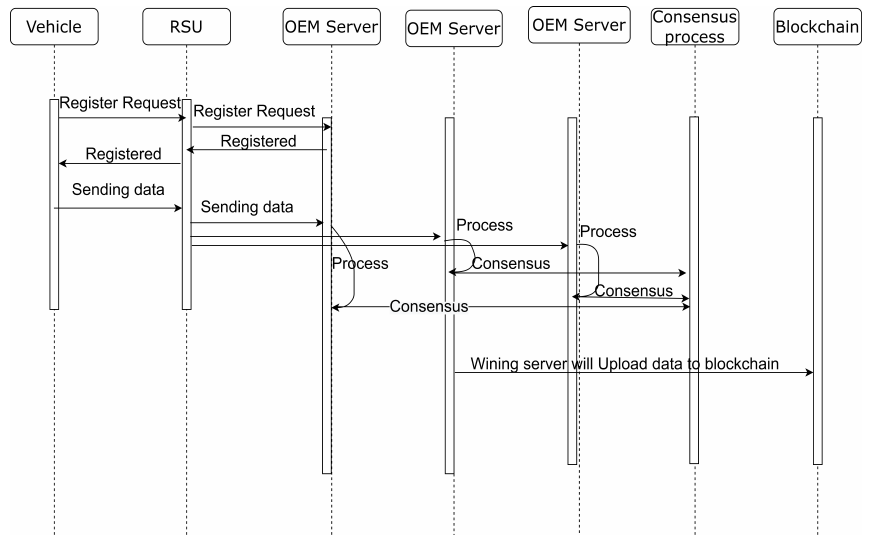
Figure 10. The sequence diagram of the proposed